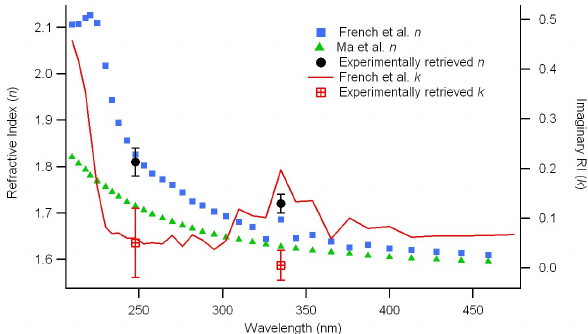
Figure 1. The refractive index values from the literature reported and extrapolated to UV wavelengths are shown here. The literature values are used in as an input for Mie theory to allow comparison with experimental results. The left axis displays the values for the real portion of the refractive index ( n ) with the French et al. (2007) values shown as blue squares and the Ma et al. (2003) values shown as green triangles. The experimentally retrieved values for n are displayed as solid black circles including uncertainty. The imaginary portion of the refractive index ( k ) is reported on the right axis where the French et al. (2007) data from the literature is shown as a connected red line and the experimentally retrieved k values are given as red grid boxes.